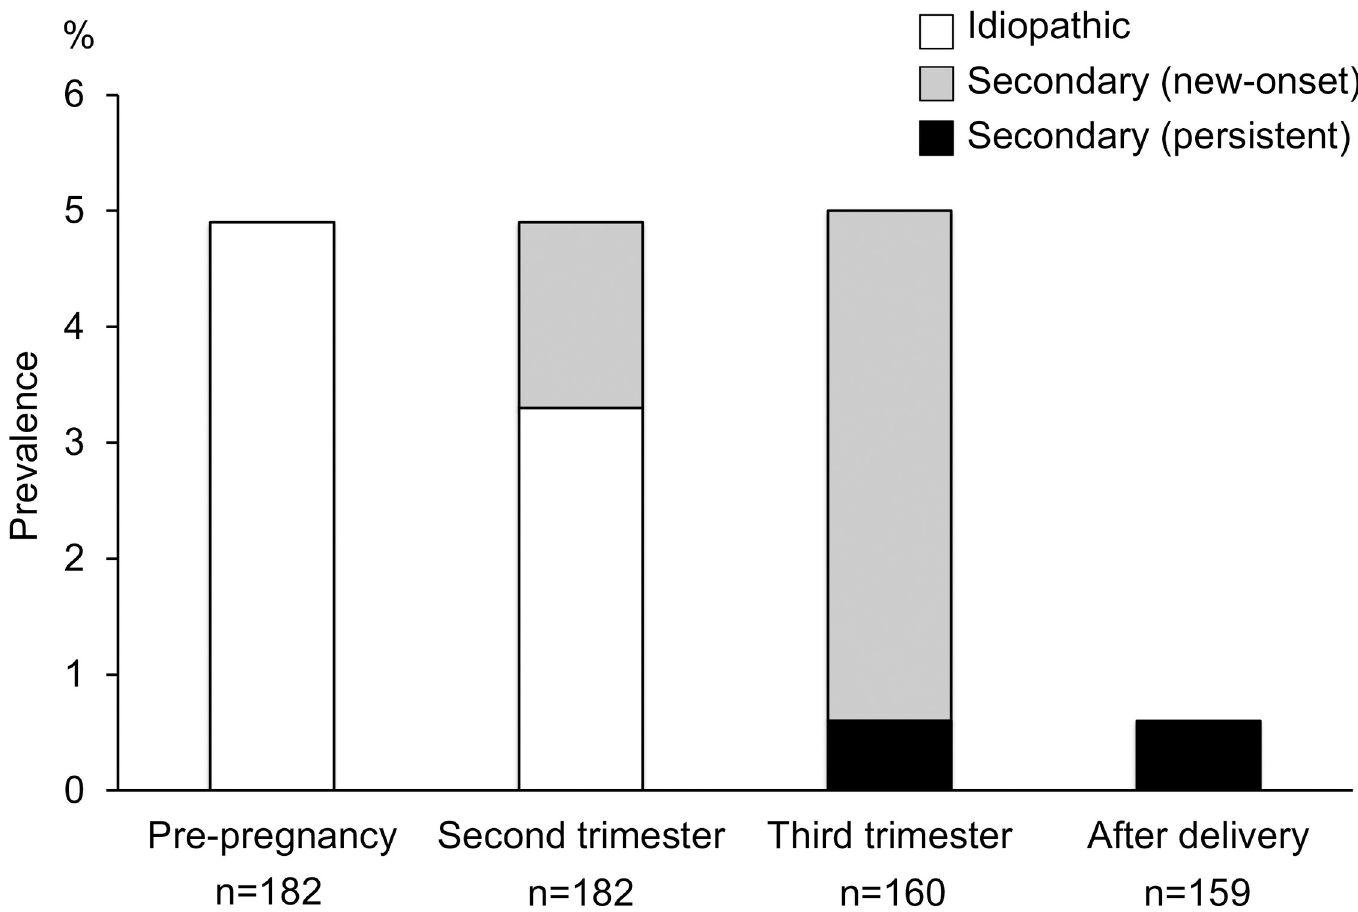
Fig 1. Prevalence of idiopathic and secondary restless legs syndrome.